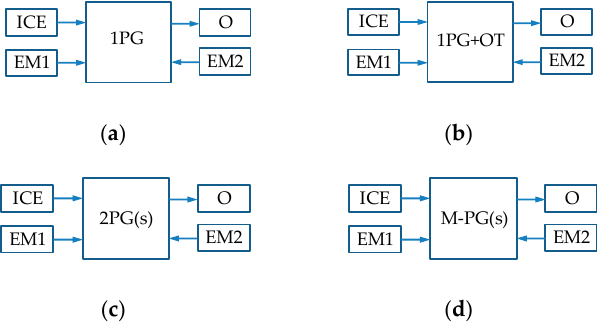
Figure 17. Four architecture types of two EMs PHP: ( a ) type-a; ( b ) type-b; ( c ) type-c; ( d ) type-d. (OT—other transmission; M-PG(s)—multi-planetary gear(s)).